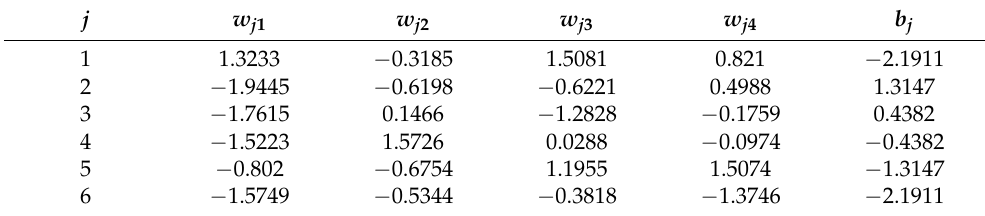
Table 6. Weights and bias of the optimized ANN architecture for the input to the first hidden layer.